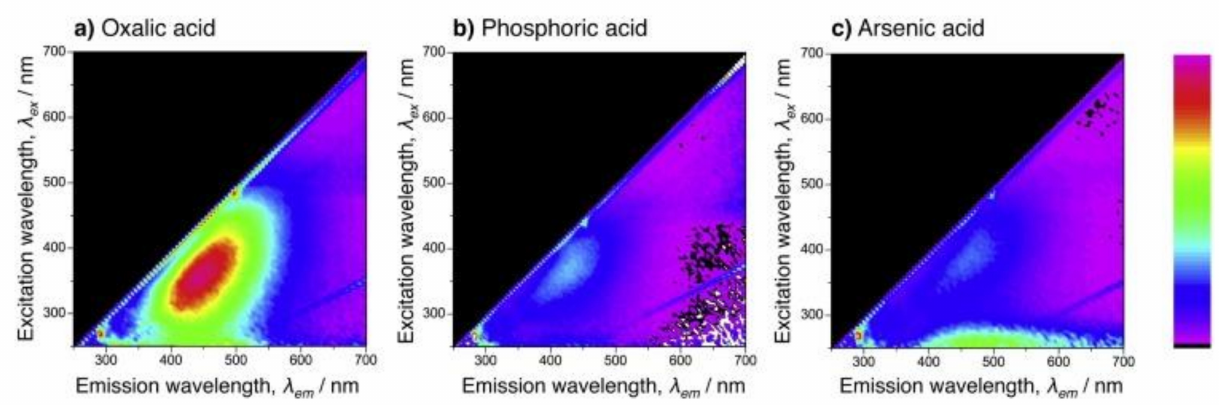
Figure 7. Excitation-emission-intensity maps of the porous alumina formed by anodizing in ( a ) oxalic acid, ( b ) phosphoric acid, and ( c ) arsenic acid solutions. The scale to the right indicates the relative intensity of the photoluminescence emission. For the oxalic and phosphoric acid anodizing processes, the electropolished specimens were anodized in 0.3 M electrolyte solutions (293 K) at a constant current density of 20 A m − 2 for 2 h. Reproduced with permission from Ref. [95]. Copyright 2017 Elsevier